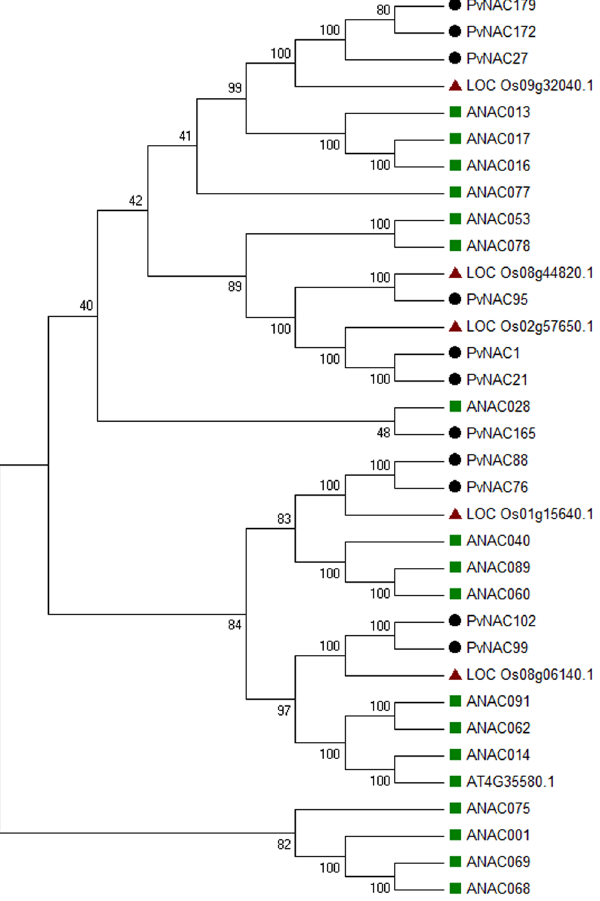
Figure 2. Phylogenetic relationship of NAC MTFs from switchgrass, rice, and Arabidopsis . Multiple sequences alignment of NAC MTFs was conducted using ClustalX, and MEGA5.0 was used to construct phylogenetic tree by using Neighbor-joining method with 1000 bootstrap replicates and p-distance method, and bootstrap values are shown next to the